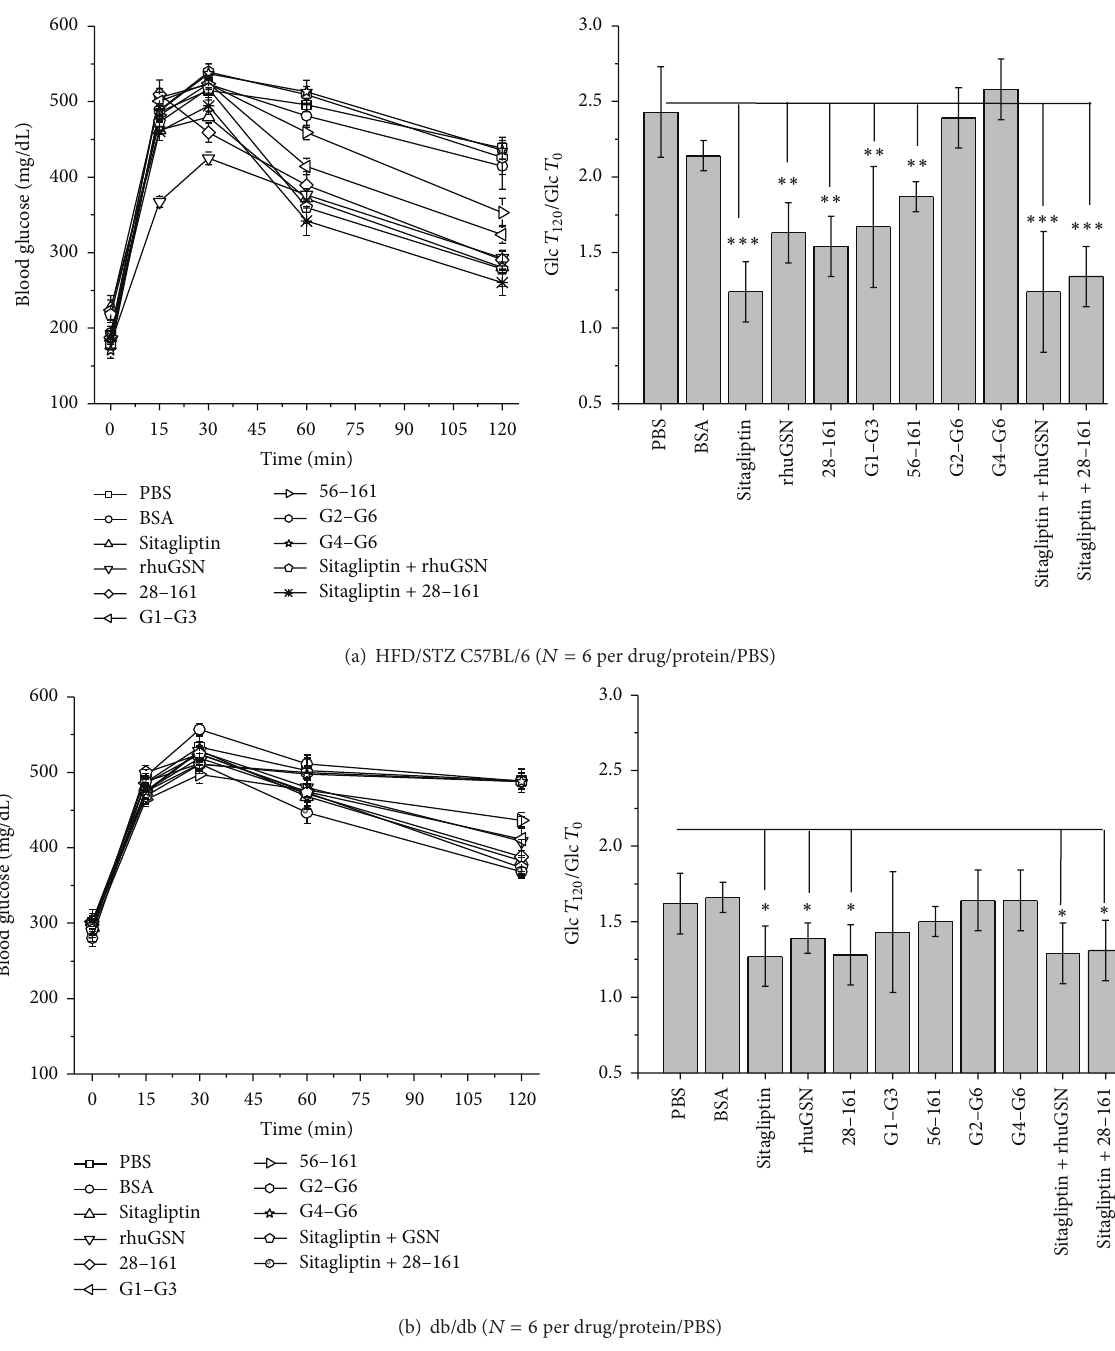
Figure 2: Blood glucose levels measured in oral glucose tolerance test (OGTT) experiments with (a) high fat diet and Streptozotocin induced (HFD/STZ) C57BL/6 and (b) db/db mice are plotted here. Left panels show the variation in the blood glucose value as a function of time, and the right panels have plots of g 𝑇 120 /g 𝑇 0 ratios for different treatments shown in left panels. The results are expressed as mean ± S.E.M. 𝑃 values are as mentioned in Methods (Section